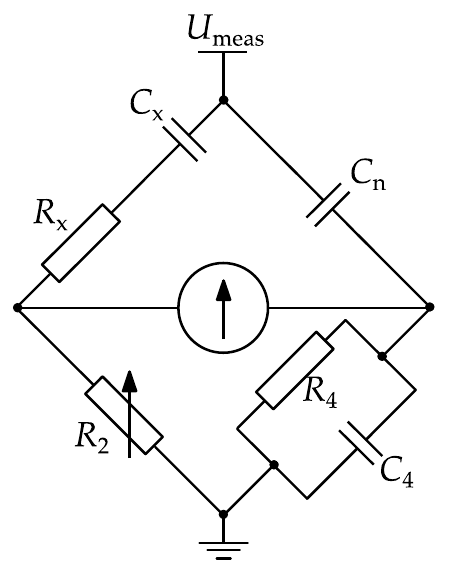
Figure 7. Schering Bridge.